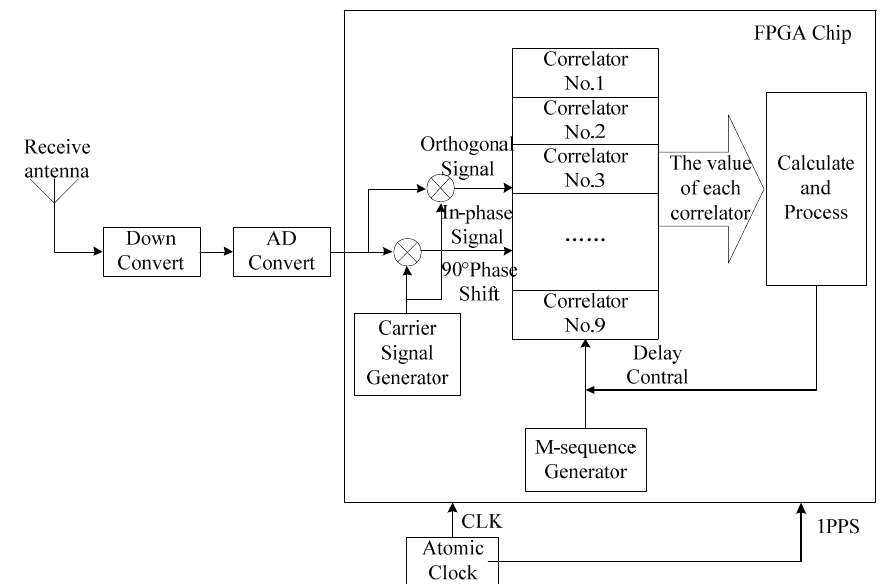
Figure 8. The structure of the baseband signal processing module based on FPGA.